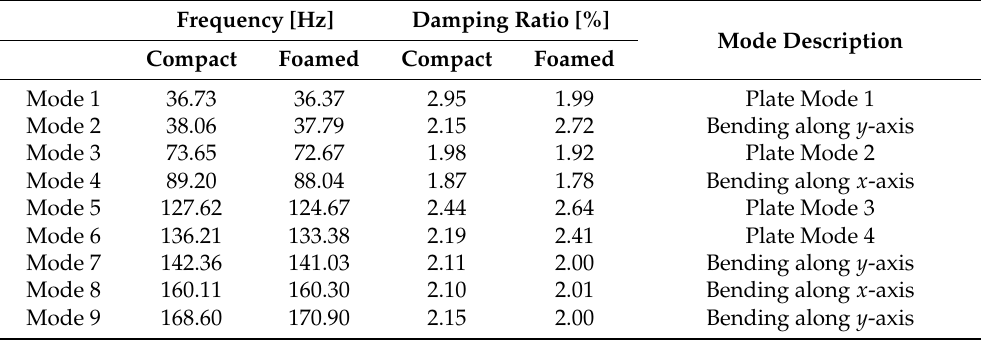
Table 6. Estimated natural frequencies, mode descriptions, and damping ratios for the first nine modes of door